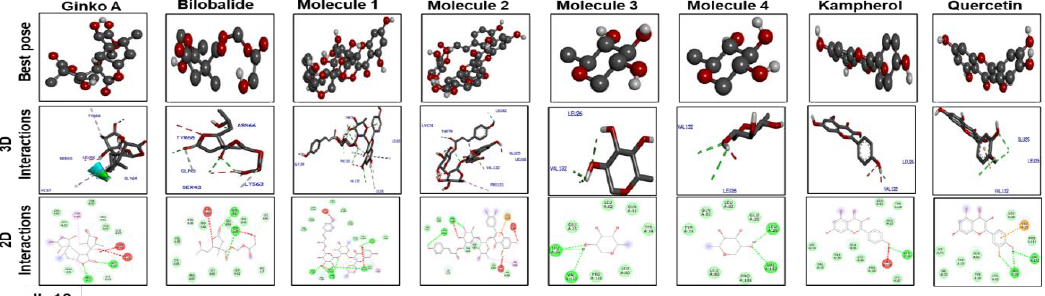
Figure 7. Docking results and best pose of ginkgolide A, bilobalide, 3-O-(2′-O-(6′-O-(p-coumaroyl)-β- D -glucosyl)-α- L - rhamnosyl)kaempferol (Molecule 1), 3-O-(2′-O-(6′-O-(p-coumaroyl)-β- D -glucosyl)-α- L-rhamnosyl) quercetin (Molecule 2), 3-O-(2′-O,6′-O-bis(α- L -rhamnosyl)-β- D -glucosyl) kaempferol (Molecule 3), 3-O-(2′-O,6′-O-bis(α- L -rhamnosyl)-β- D -glucosyl) quercetin (Molecule 4), quercetin, and kaempferol, after docking with IL-1β. Both 2D and 3D shapes of the drug-receptor complex were visualized by DSV.